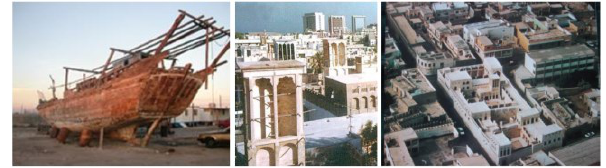
Figure 1. Heritage characteristics for each heritage area (Al- Kubaisy, 2010).